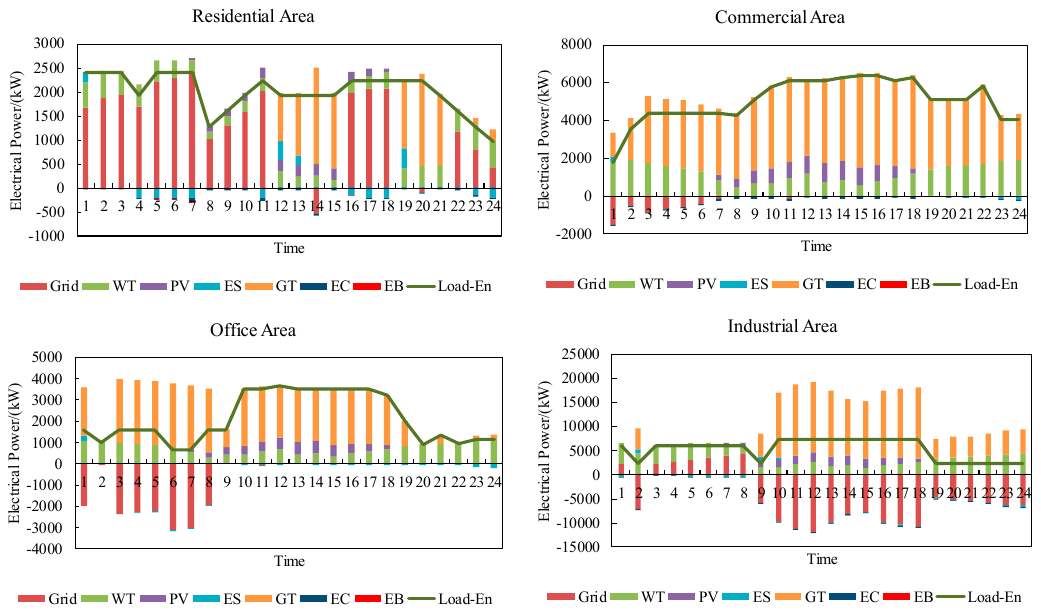
Figure 9. Dispatching results of electric power.